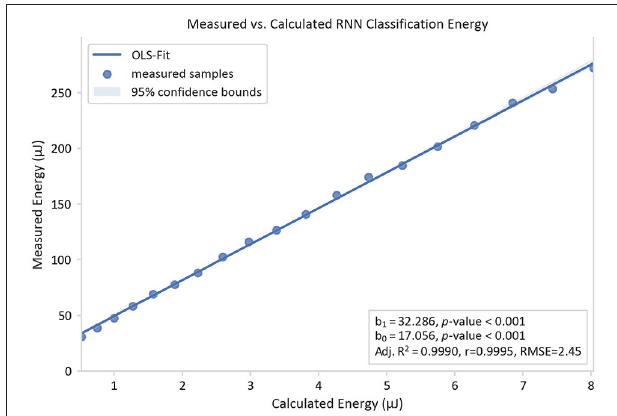
FIGURE 8 | Measured classification energy over the calculated energy and its linear regression curve. The energies are determined by measuring the energy of an RNN implementation on an Apollo 3 Blue ARM Cortex-M4F microcontroller unit under the variation of the number of LSTM cells from 2 to